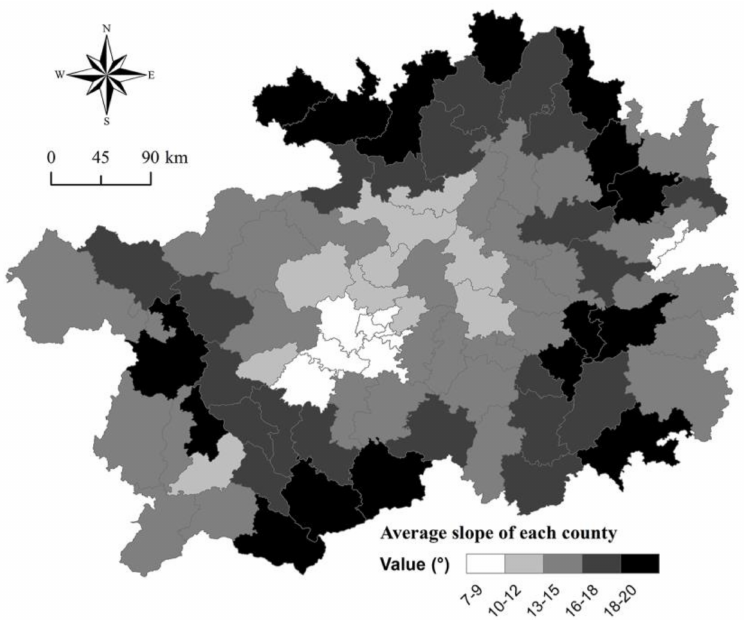
Figure 8. Distribution of average slope at the county